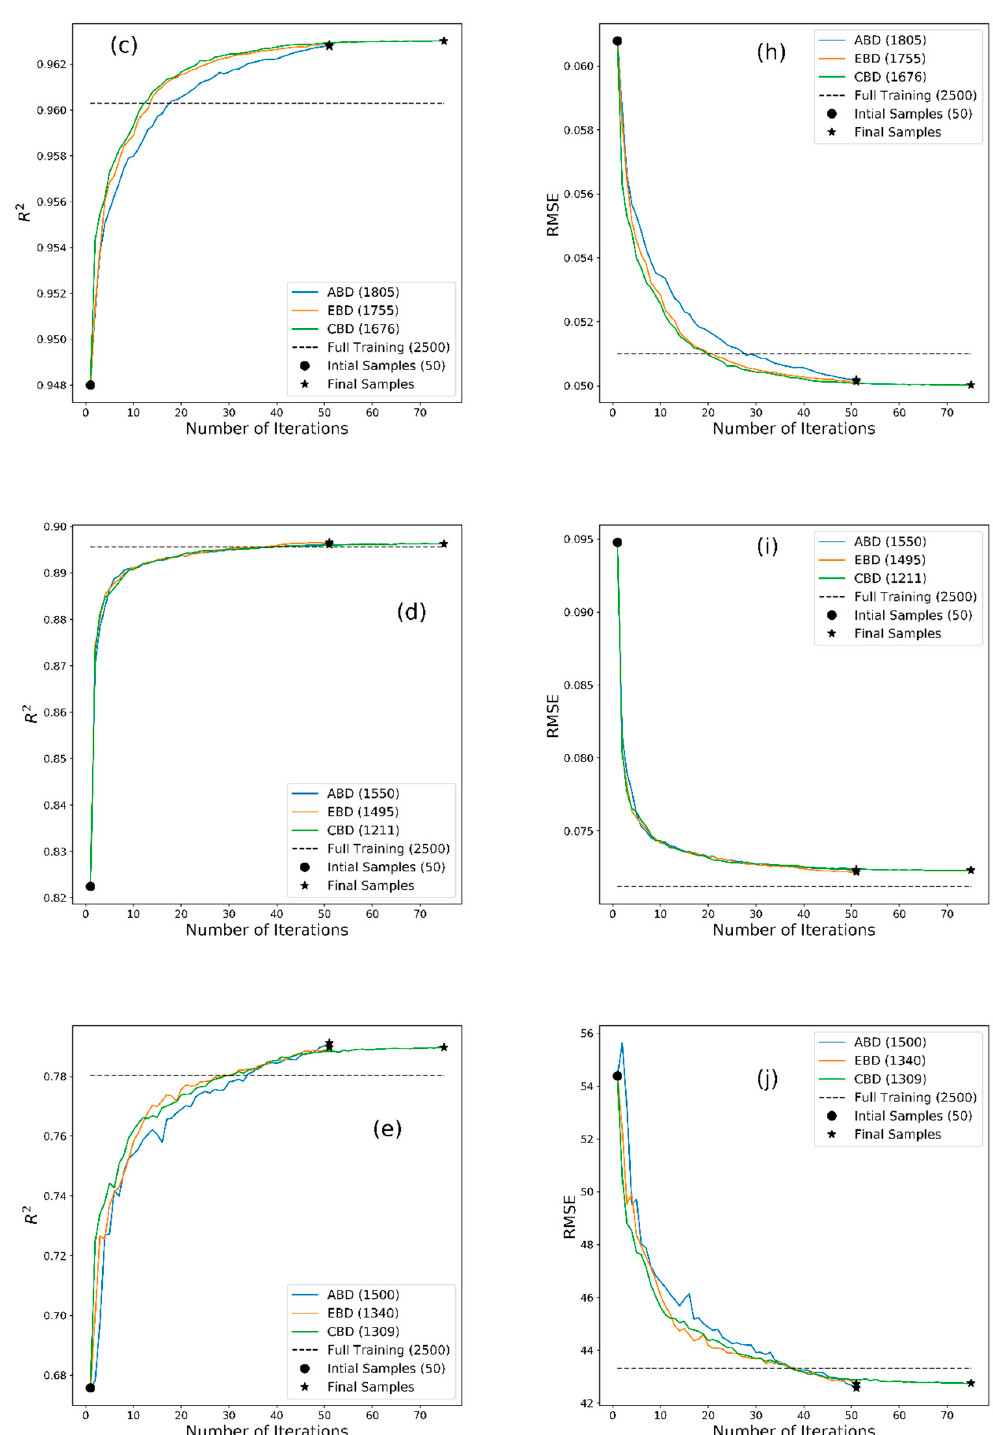
Figure 2. Comparison of three diversity criteria of data pool samples selection in AL, i.e. angle-based diversity (ABD), Euclidean distance-based diversity (EBD), and cluster-based diversity (CBD) for the different biophysical variables for the Maccarese dataset. ( a , f ) LAI; ( b , g ) LCC; ( c , h ) FVC ( d , i ) FAPAR; ( e , j ) CCC. The values in parentheses in the legend indicate the final size of the training dataset after the Active learning process. The star symbol indicates the final samples after reaching the AL stopping criteria (see text). The horizontal dashed line indicates the performance of the GPR training with the full dataset of 2500 samples without